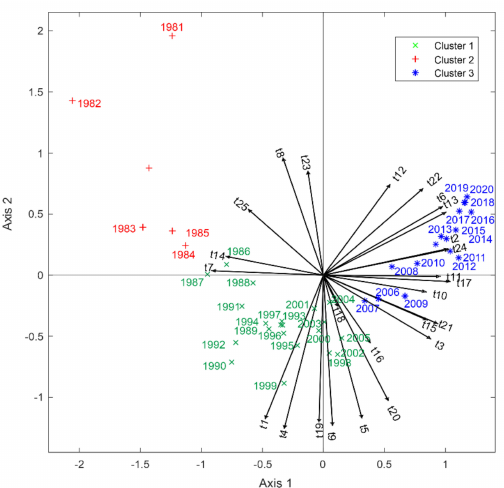
Figure 9. Association between topics by year using the HJ-Biplot method. A small acute angle means a positive relation; a plane angle (Formed by two right angles 180 ◦ ), negative relation; and a straight angle (Formed by two perpendicular lines 90 ◦ ), no relation. The segments (lines) represent each of the variables (topics); the colors red, blue, and green represent groups of years with respect to the